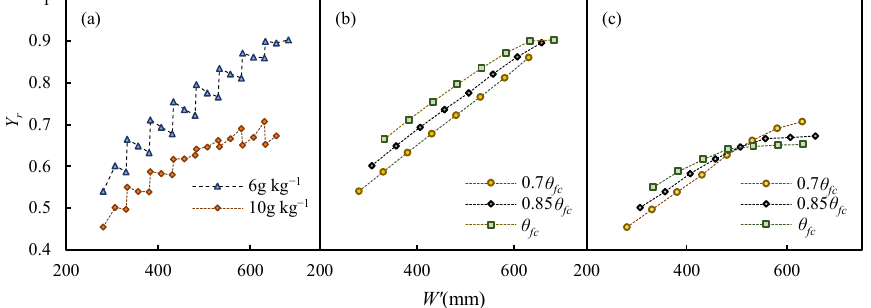
Figure 5. Change in relative yield ( Y r ) with respect to W’ : ( a ) when S0 = 6 g kg − 1 and K = 3 g L − 1 and when S0 = 10 g kg − 1 and K = 3 g L − 1 ; ( b ) when S0 = 6 g kg − 1 and K = 3 g L − 1 for di ff erent values of W0 ; ( c ) when S0 = 10 g kg − 1 and K = 3 g L − 1 for di ff erent values of W0 . Note: W’ is available water for the entire crop growth period; S0 is initial soil salt content; K is irrigation water salinity level; W0 is initial soil moisture content.